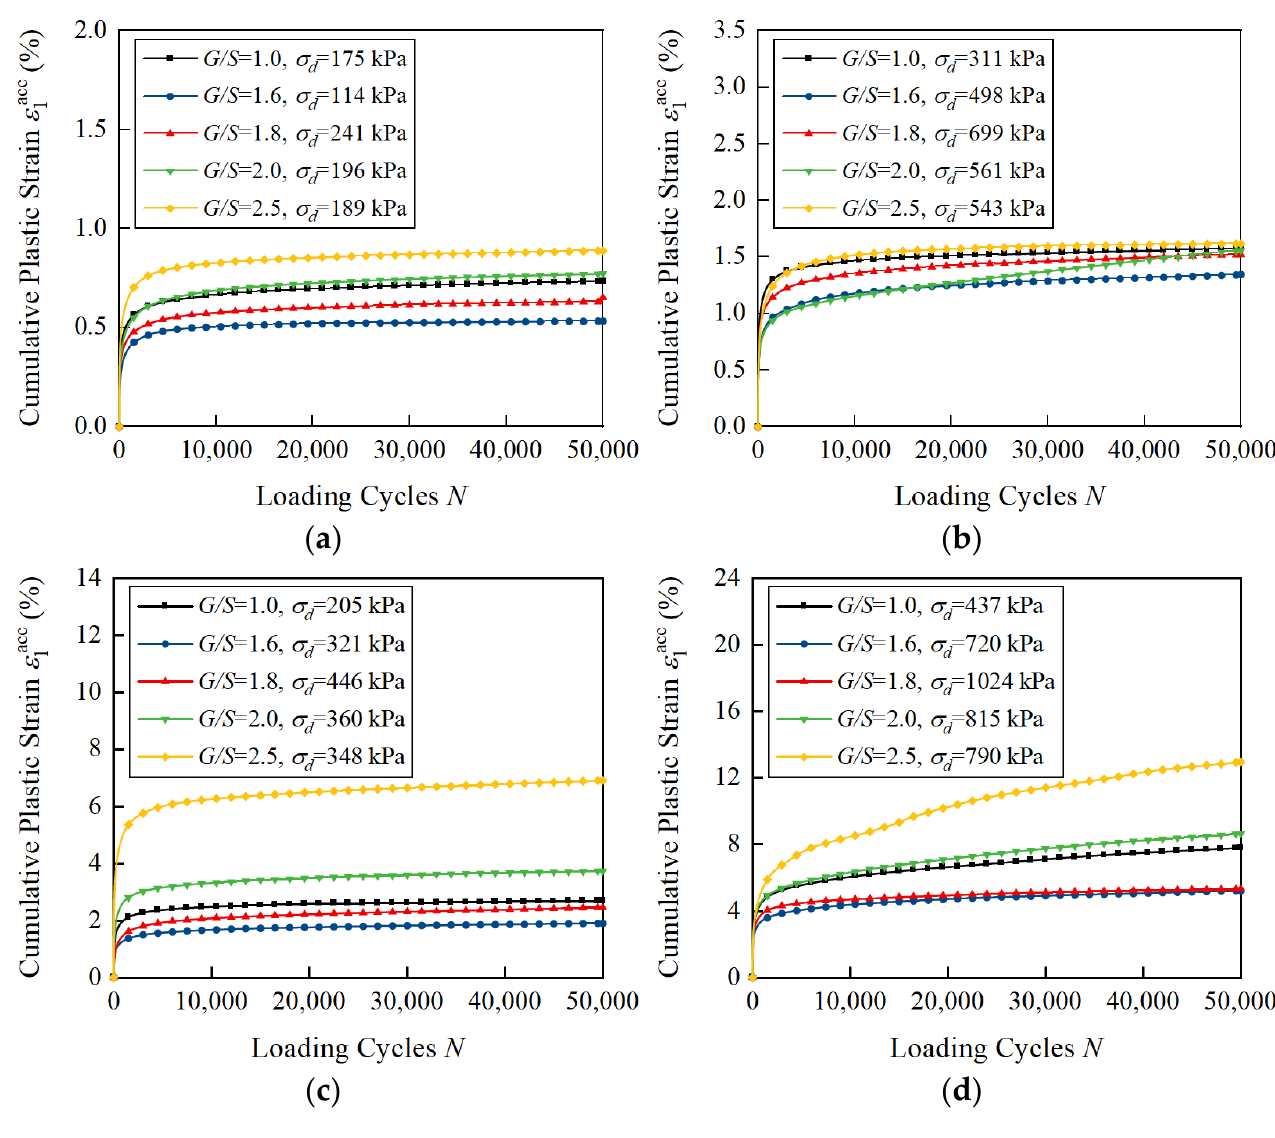
Figure 10. Laboratory-measured permanent deformation of unbound aggregate base materials with different G / S values under confining pressure of 150 kPa: ( a ) SSR = 0.3; ( b ) SSR = 0.5; ( c ) SSR = 0.7; ( d ) SSR = 0.9.